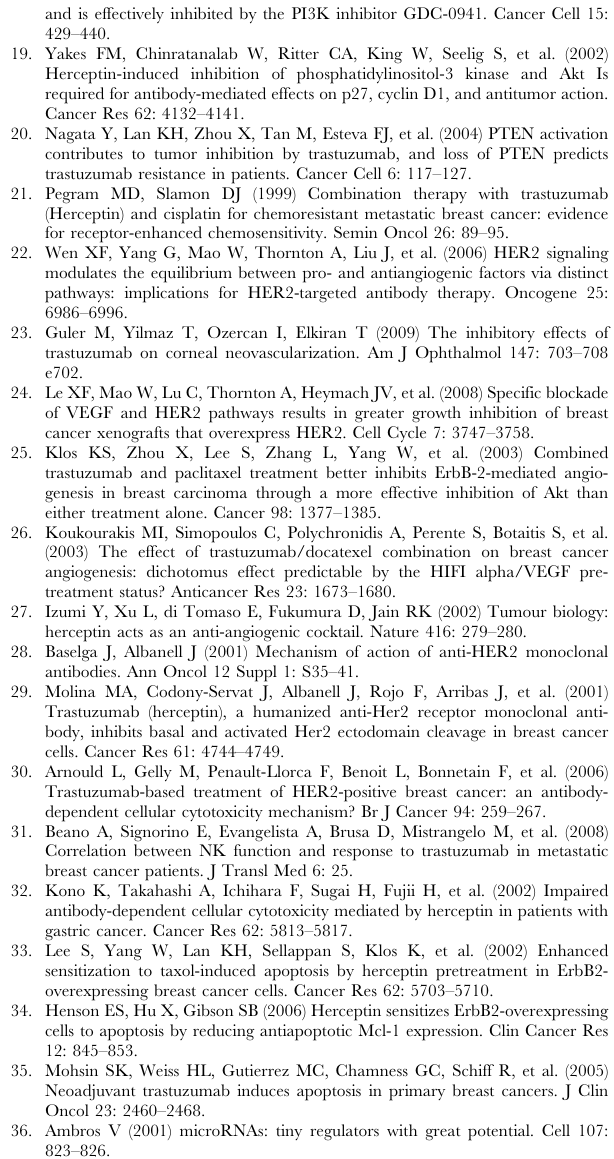
BTHCT48, BT474 cells treated with trastuzumab for 48 hrs. A color scale of expression is shown between panel A and B. (TIF) Figure S2 Effects of trastuzumab on miR-194 expres- sion in the MDA-MB-231 cells with low-HER2 level and the KPL4 cells with high-HER2 level. Two trastuzumab- insensitive breast cancer cell lines MDA-MB-231 ( A ) and KPL4 ( B ) were treated with trastuzumab (Tras) at different concentra- tions (0, 5, 10 m g/ml) for 48 hrs. Total RNA was prepared and analyzed by QRT-PCR in triplicate for miR-194 levels.